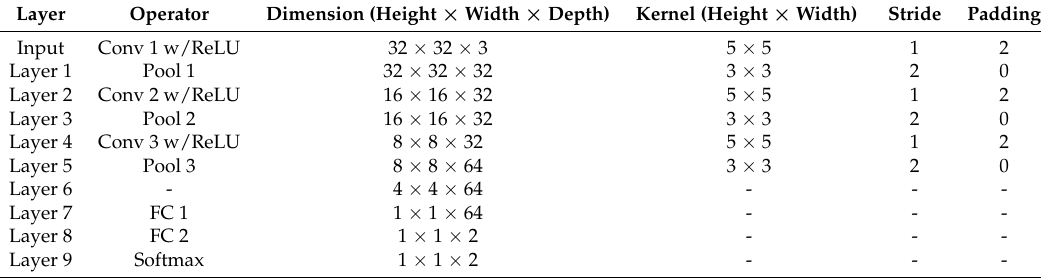
Figure 4. Schematic of the deep learning architecture. Table 1. Information of each layer of the deep learning